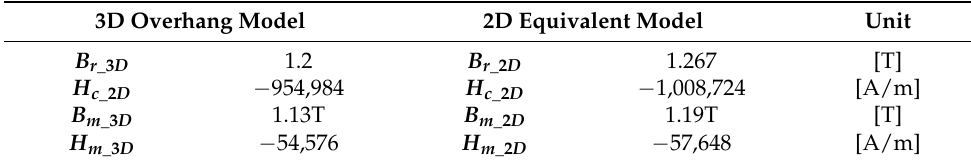
Table 2. Overhang PM magnetic field energy